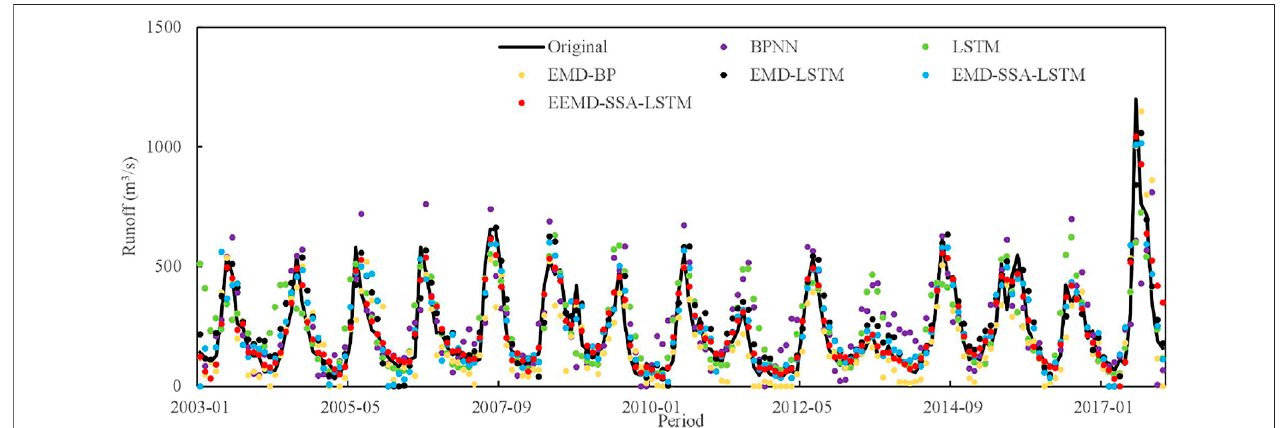
FIGURE 4 | Comparison of the forecast results for the Guangzhao Reservoir during the validation period.